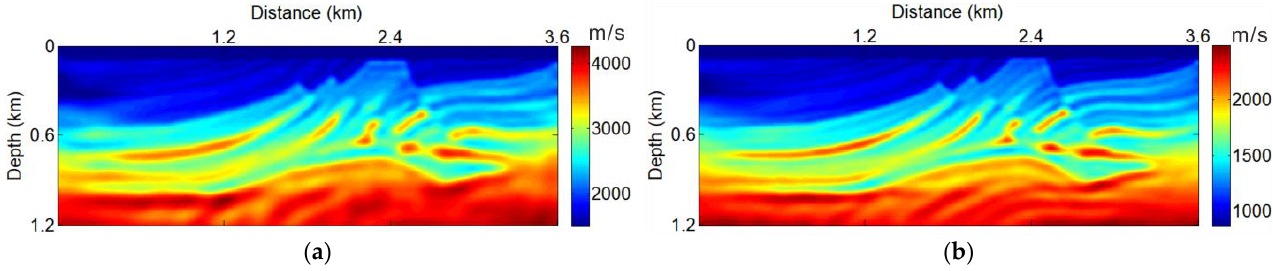
Figure 10. Low-frequency data (5 – 10 Hz) based conventional EFWI results using Figure 9 for the initial velocity models. ( a ) V p ; ( b ) V s .